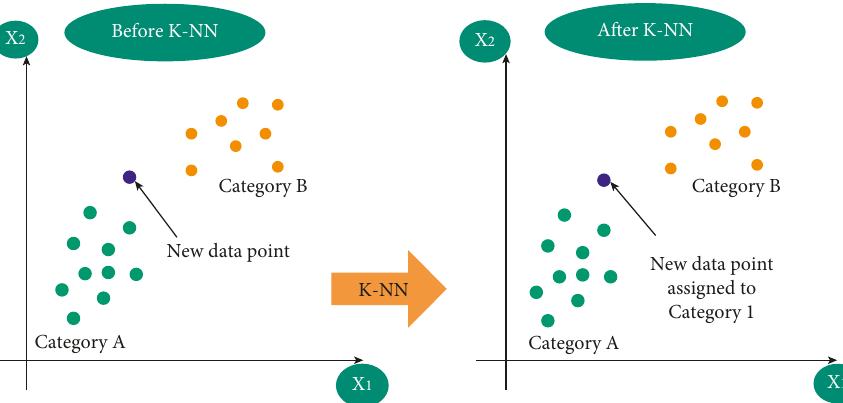
Figure 5: Illustration of KNN technique (adapted from JavaTpoint).